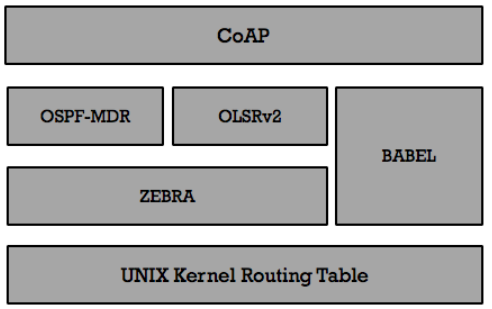
Figure 5. SDN Protocol